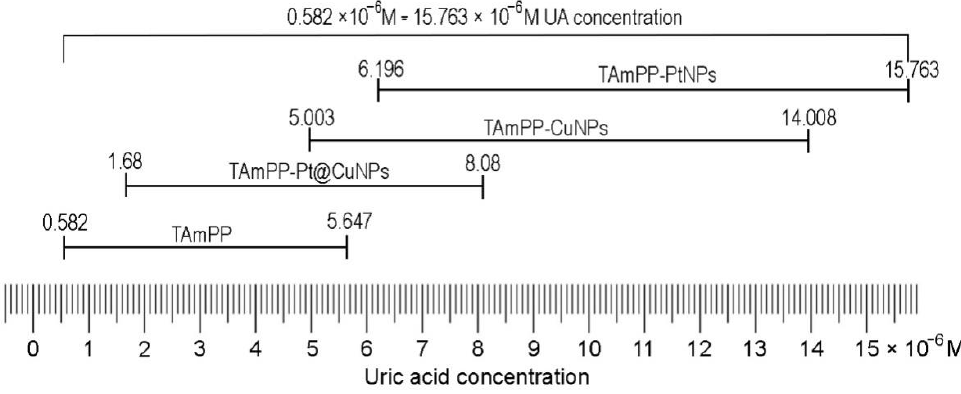
Figure 24. The field of UA detection covered by the materials containing TAmPP used in this study.